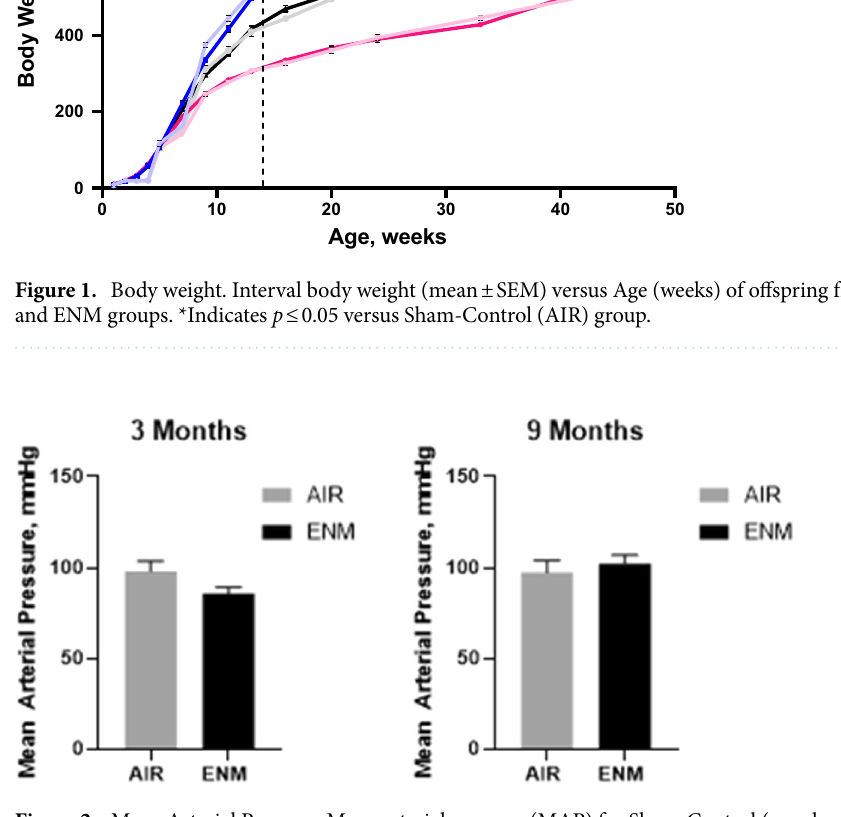
Figure 2. Mean Arterial Pressure. Mean arterial pressure (MAP) for Sham-Control (gray bars) and ENM (black bars) offspring at 3 and 9 months of age. Values are shown as mean ± SEM.